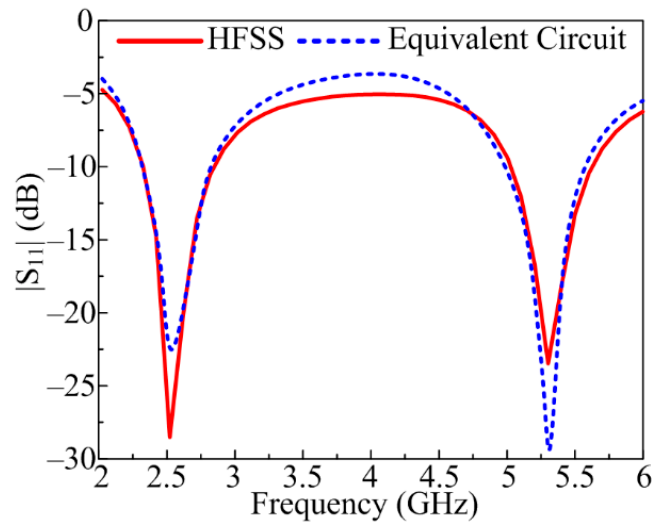
Figure 6. |S 11 | comparison of antenna designed using HFSS and equivalent circuit model.